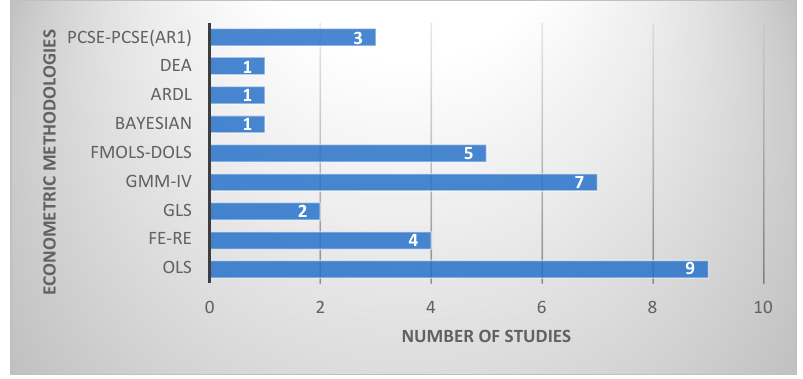
Figure 6. The econometric methodologies used in relation to the number of studies on the nexus between corruption and energy prices .